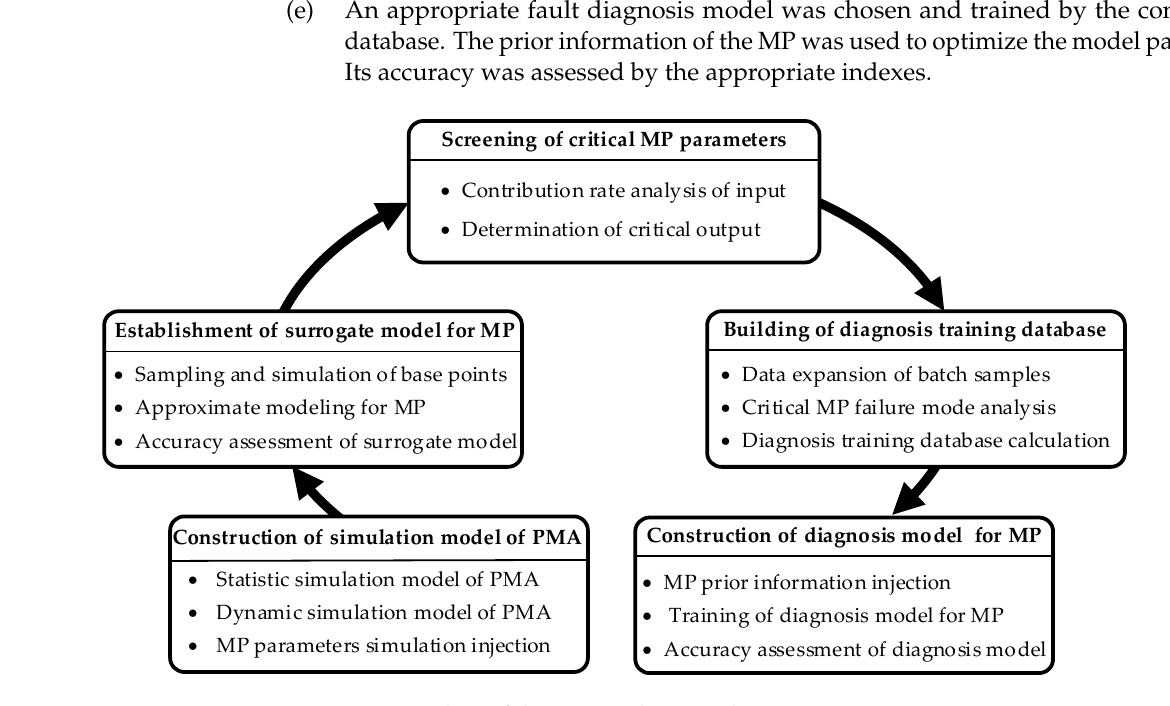
Figure 2. Procedure of the proposed approach.